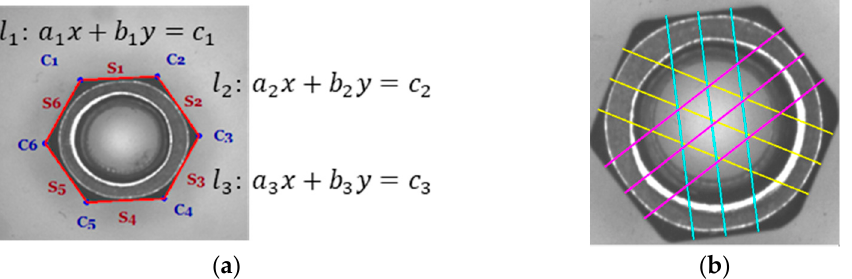
Figure 7. Calculate the length of the opposite side using three equally spaced perpendicular lines drawn for each parallel line: ( a ) Corner; ( b ) There are three sets of opposite side lengths, and each set has three lines.